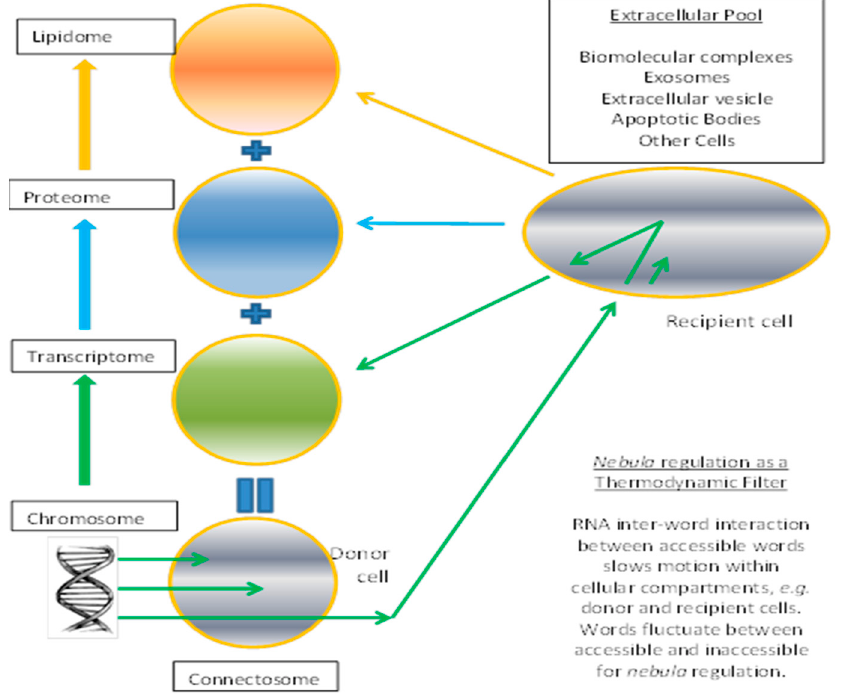
Figure 1. Establishment of transcriptome as result of anomalous diffusion of RNA. Black represents DNA, green represents RNA, while blue and orange represent proteins and lipids respectively. Arrows denote flow of information from donor cell, to extracellular pool, to recipient cell. Biological connectosome maps to schema of enhancements in Cartesian Genetic Programming (CGP).